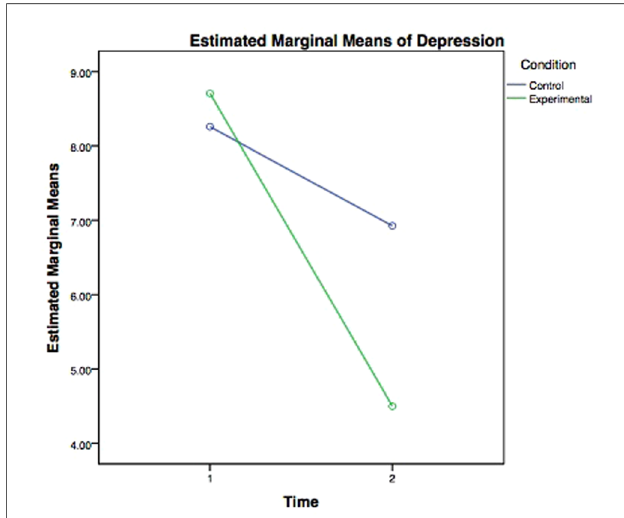
FIGURE 1 Estimated marginal means of depression for participants across time by condition.